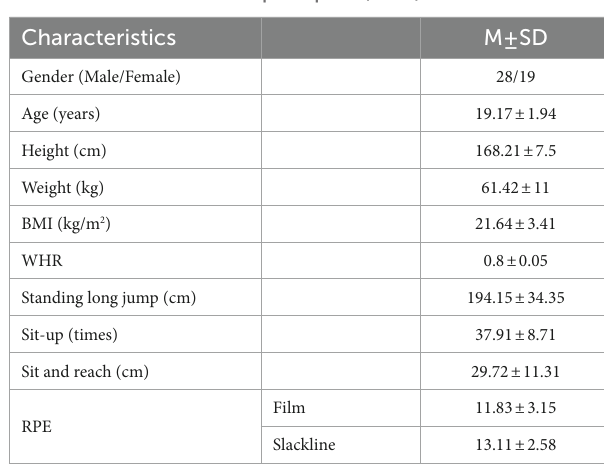
TABLE 1 Characteristics of the participants ( N = 47).